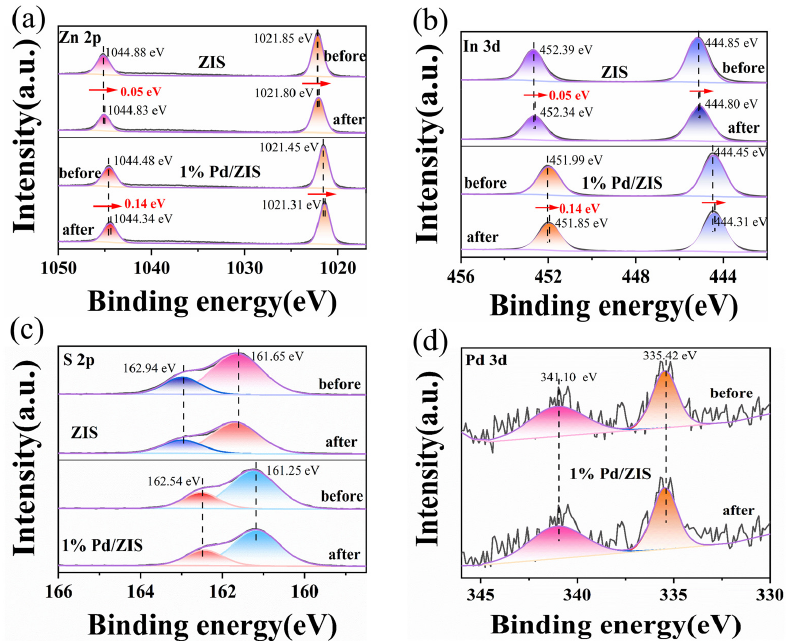
Figure 8. XPS spectra of the ZIS and 1% Pd/ZIS samples before and after pyridine adsorption: ( a ) Zn 2p; ( b ) In 3d; ( c ) S 2p; ( d ) Pd 3d.